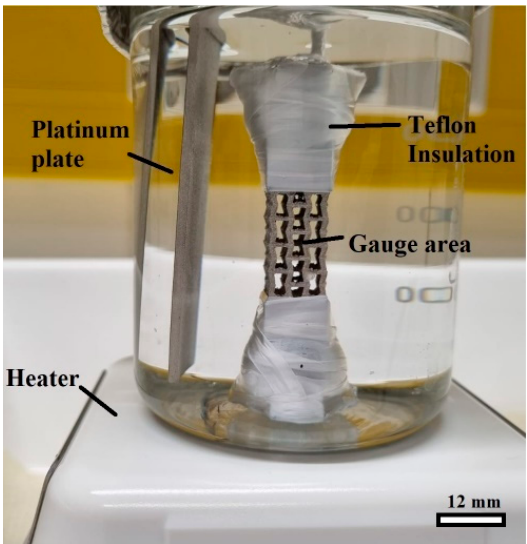
Figure 2. A photograph showing the setup during H charging of the auxetic structure.